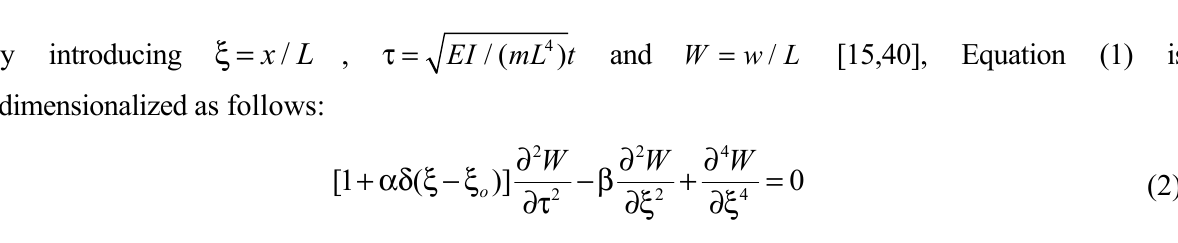
Figure 1. ( a ) Schematic diagram of an adsorbate on a carbon nanotube-based resonator; ( b ) the first three modes of a uniform clamped-clamped